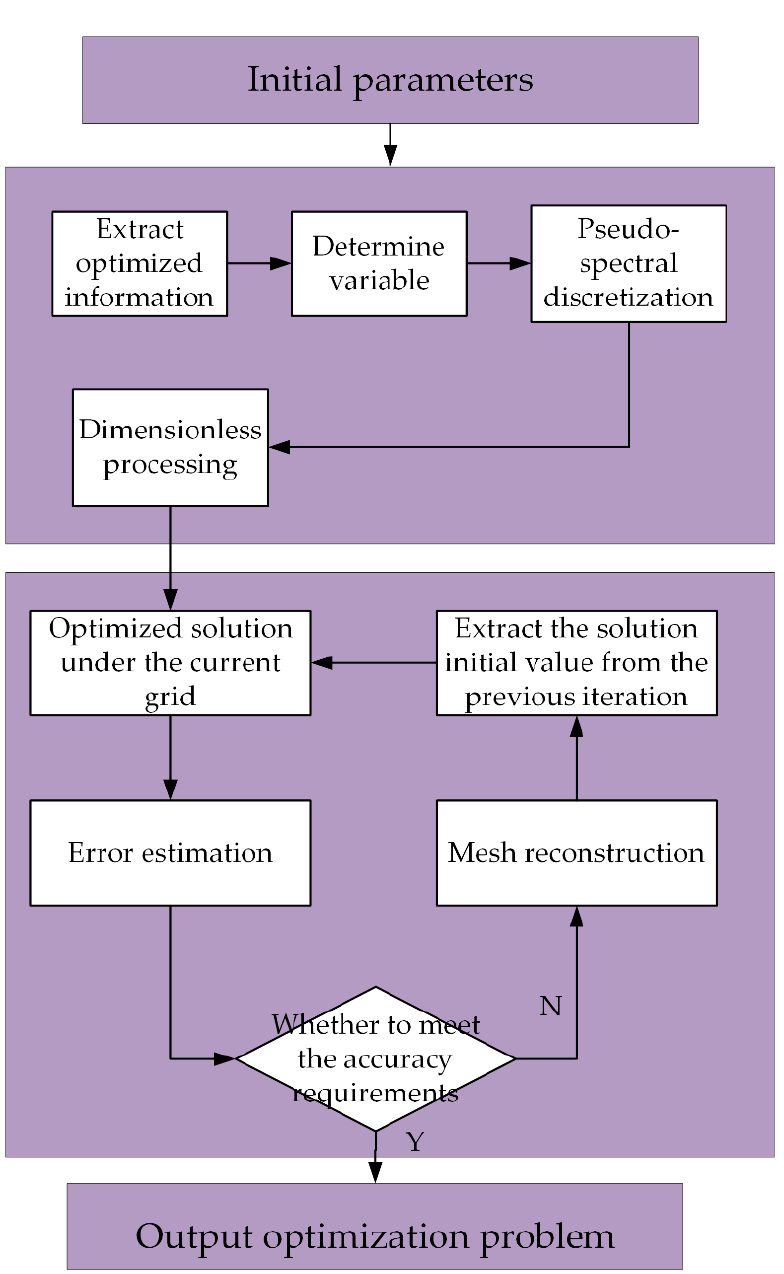
Figure 4. Algorithm flowchart.